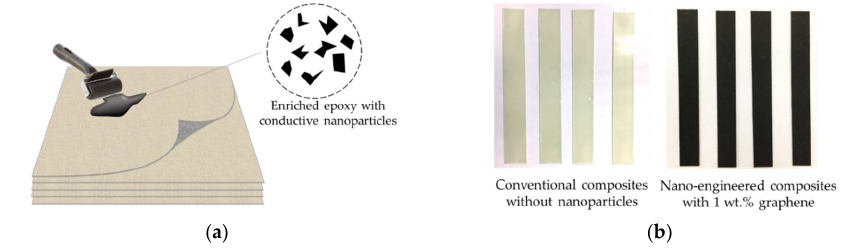
Figure 3. ( a ) Schematic of manufacturing the nano-engineered composite laminate; ( b ) Trimmed samples without/with nanoparticles (1 wt %).